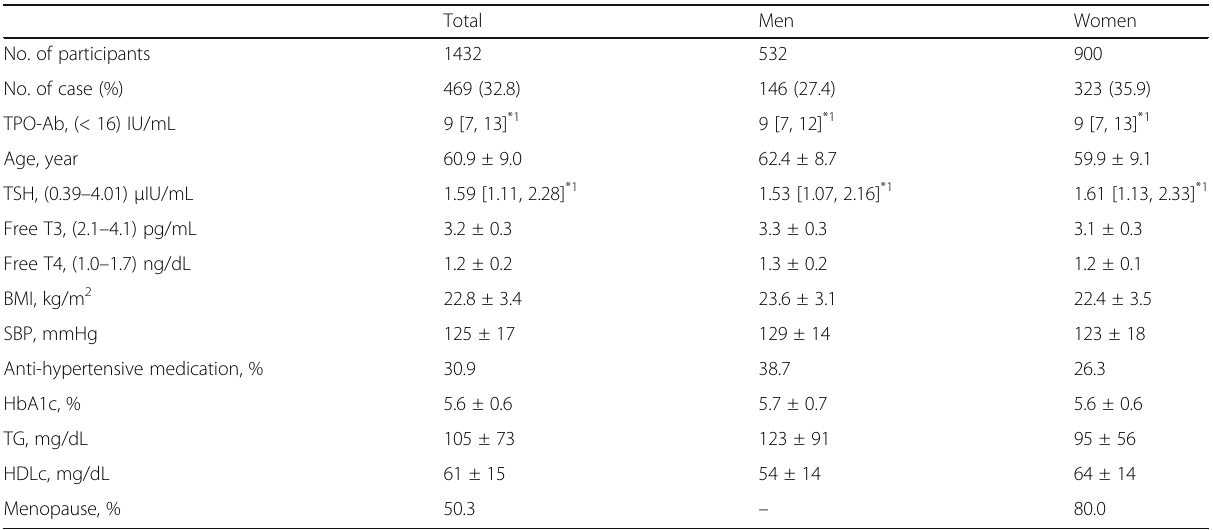
Table 1 Characteristics of the study population